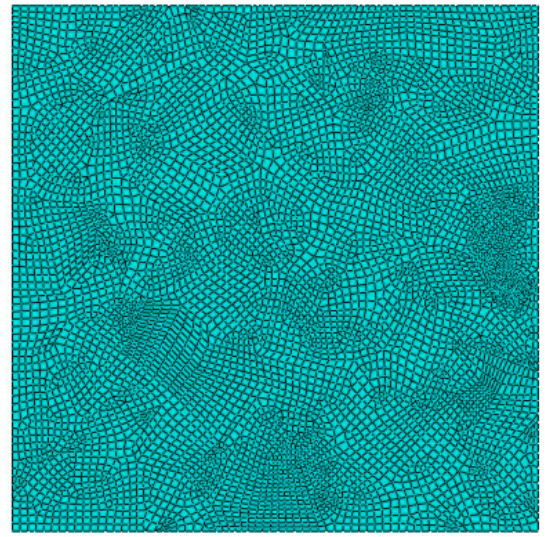
Figure 9. Meshing of the polycrystalline model.